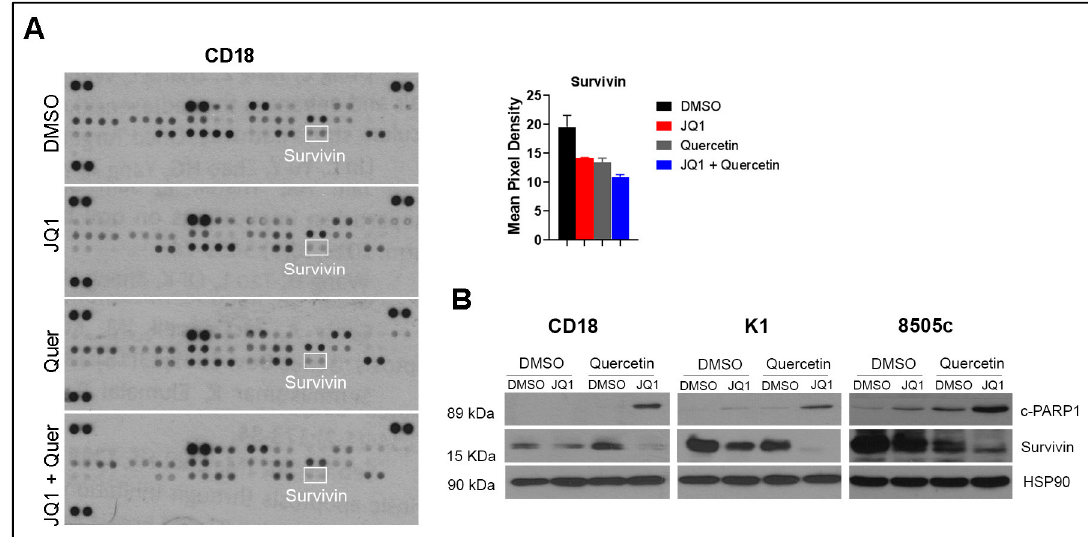
Figure 4. Co-treatment of Quercetin and JQ1 decreases Survivin. ( A ) Pancreatic cancer cells were treated with DMSO, JQ1 (1 µmol/L), Quercetin (Quer, 20 µmol/L), or a combination of JQ1 (1 µmol/L) and Quercetin (20 µmol/L) for 24 h. Cell lysates were collected and analyzed for apoptosis-related proteins using the Proteome Profiler Human Apoptosis Array ARY009, and the pixel density of Survivin from the array data was quantified by ImageJ. Error bars represent SD from two technical replicates. The results are representative of two independent experiments. Survivin is highlighted with white boxes. ( B ) Cells were treated with DMSO, JQ1 (1 µmol/L), Quercetin (20 µmol/L), or a combination of JQ1 (1 µmol/L) and Quercetin (20 µmol/L) for 24 h. The effect on c-PARP1 and Survivin was determined by western blot analysis, using HSP90 as loading control. The results are representative of three independent experiments. DMSO: dimethyl sulfoxide; JQ1: BET inhibitor; c-PARP1: cleaved PARP1; HSP90: heat shock protein 90 (loading control); SD: standard deviation; K1: human papillary thyroid cancer cell lines; 8505c: human anaplastic thyroid cancer cell line; CD18: human pancreatic cancer cell line.